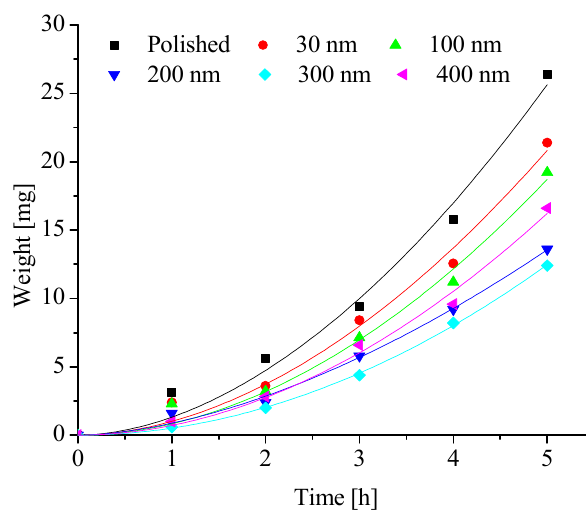
Figure 22. Testing value polynomial model regression fitting at T = − 5 °C, φ = 60%.